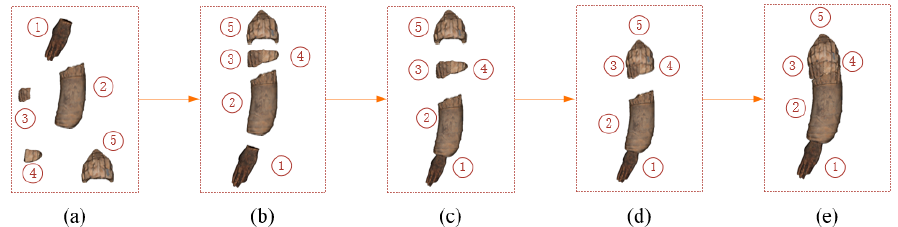
Figure 13. The reassembly result of multiple fragments from a Terracotta arm. ( a ) Five fragments; ( b ), ( c ), and ( d ) steps to reassembly; ( e ) reassembly